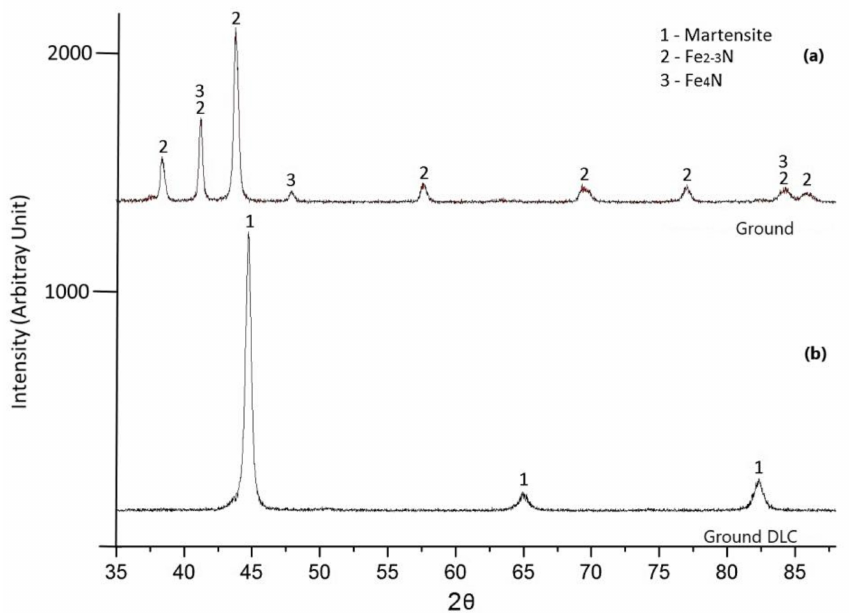
Figure 7. X-ray diffraction (XRD) diffractograms before and after plasma nitriding + DLC: ( a ) ground specimen; ( b ) nitrided specimen +